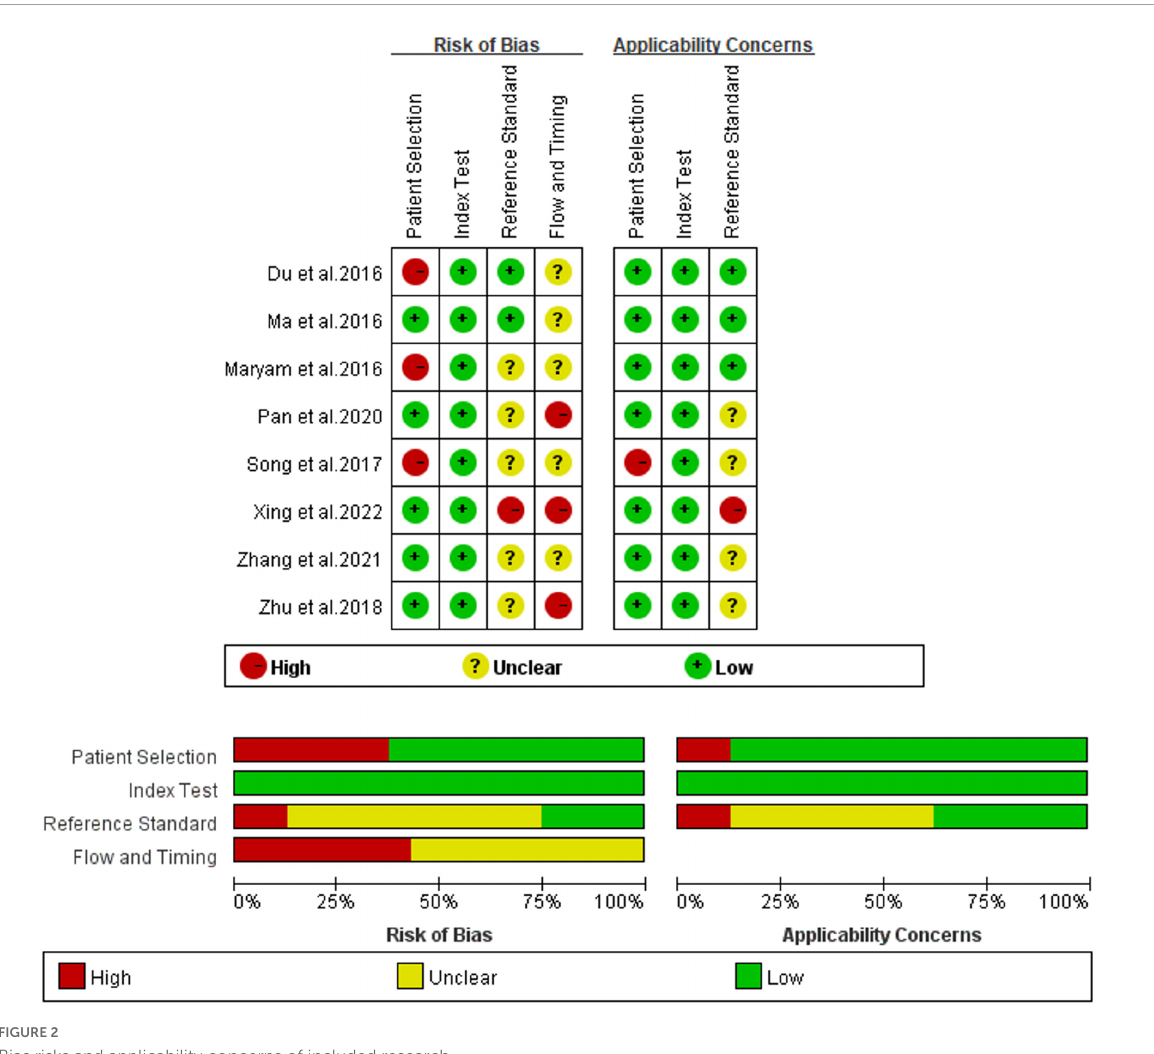
FIGURE2 Bias risks and applicability concerns of included research.